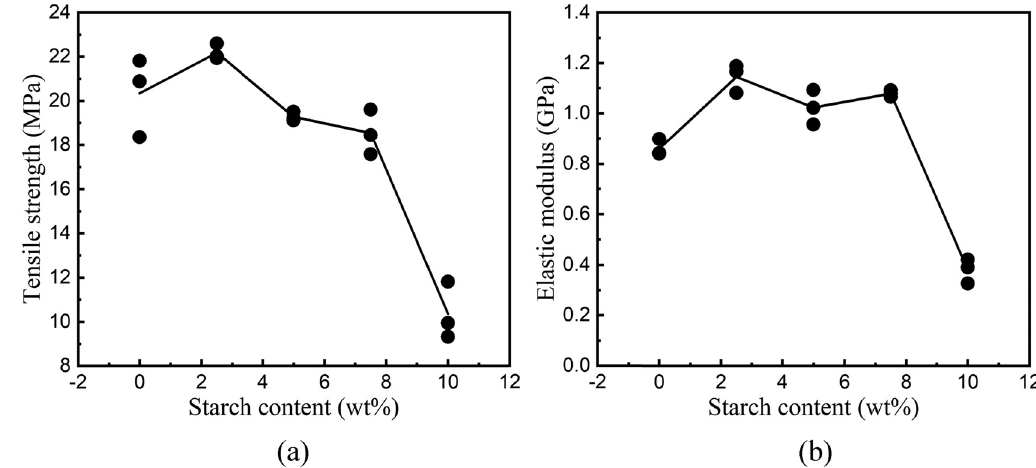
Figure 2: Plot of relative tensile strength ( a ) and elastic modulus ( b ) vs corn starch